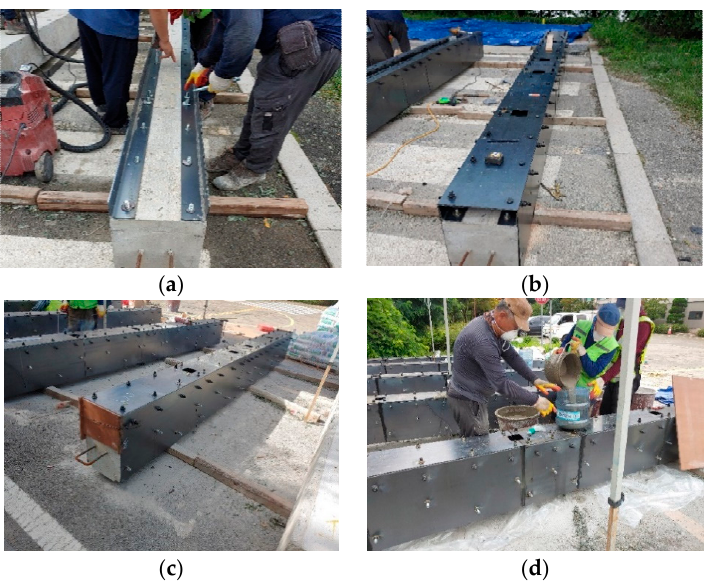
Figure 5. The process of proposed retrofitting system application: ( a ) The installation of the L-shaped lower plate; ( b ) Assembly of Z-shaped side plate and vertical grid; ( c ) The process of connecting the side plate used in chemical anchors; ( d ) The process of grouting of mortar.